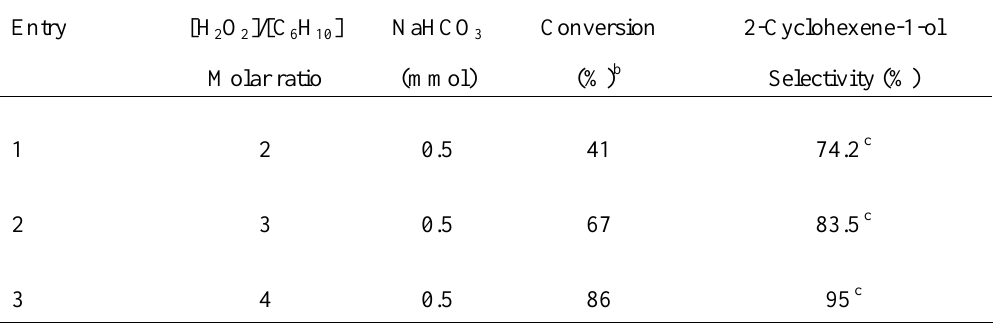
O @SiO /CPTMS/[Cu(tyr) 3 4 2